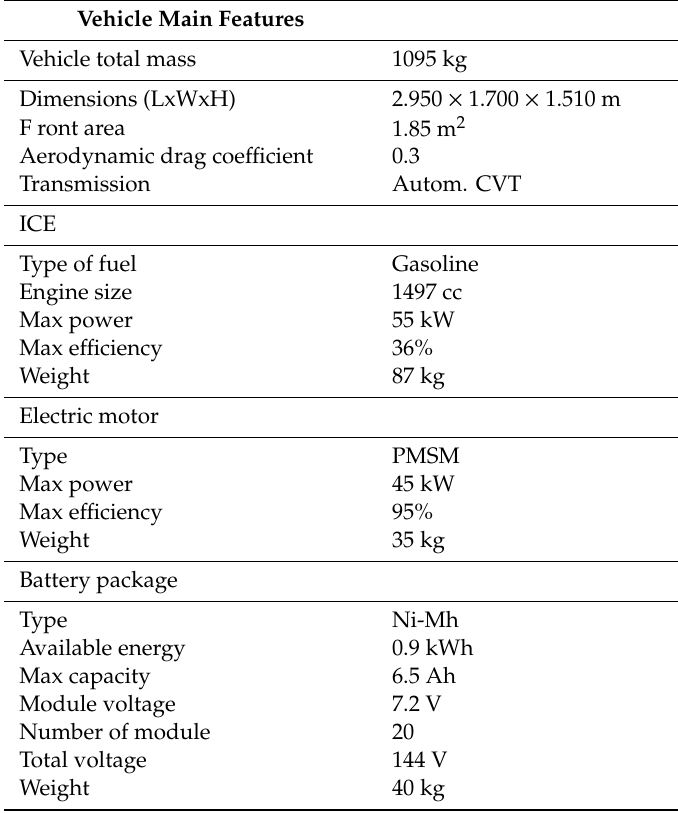
Table 19. Hybrid Vehicle